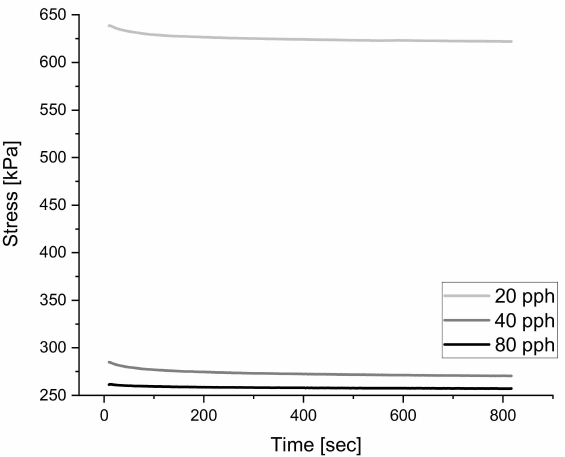
Figure 21. The influence of paraffin oil content on relaxation behavior of NR blend with 2.5 pph of